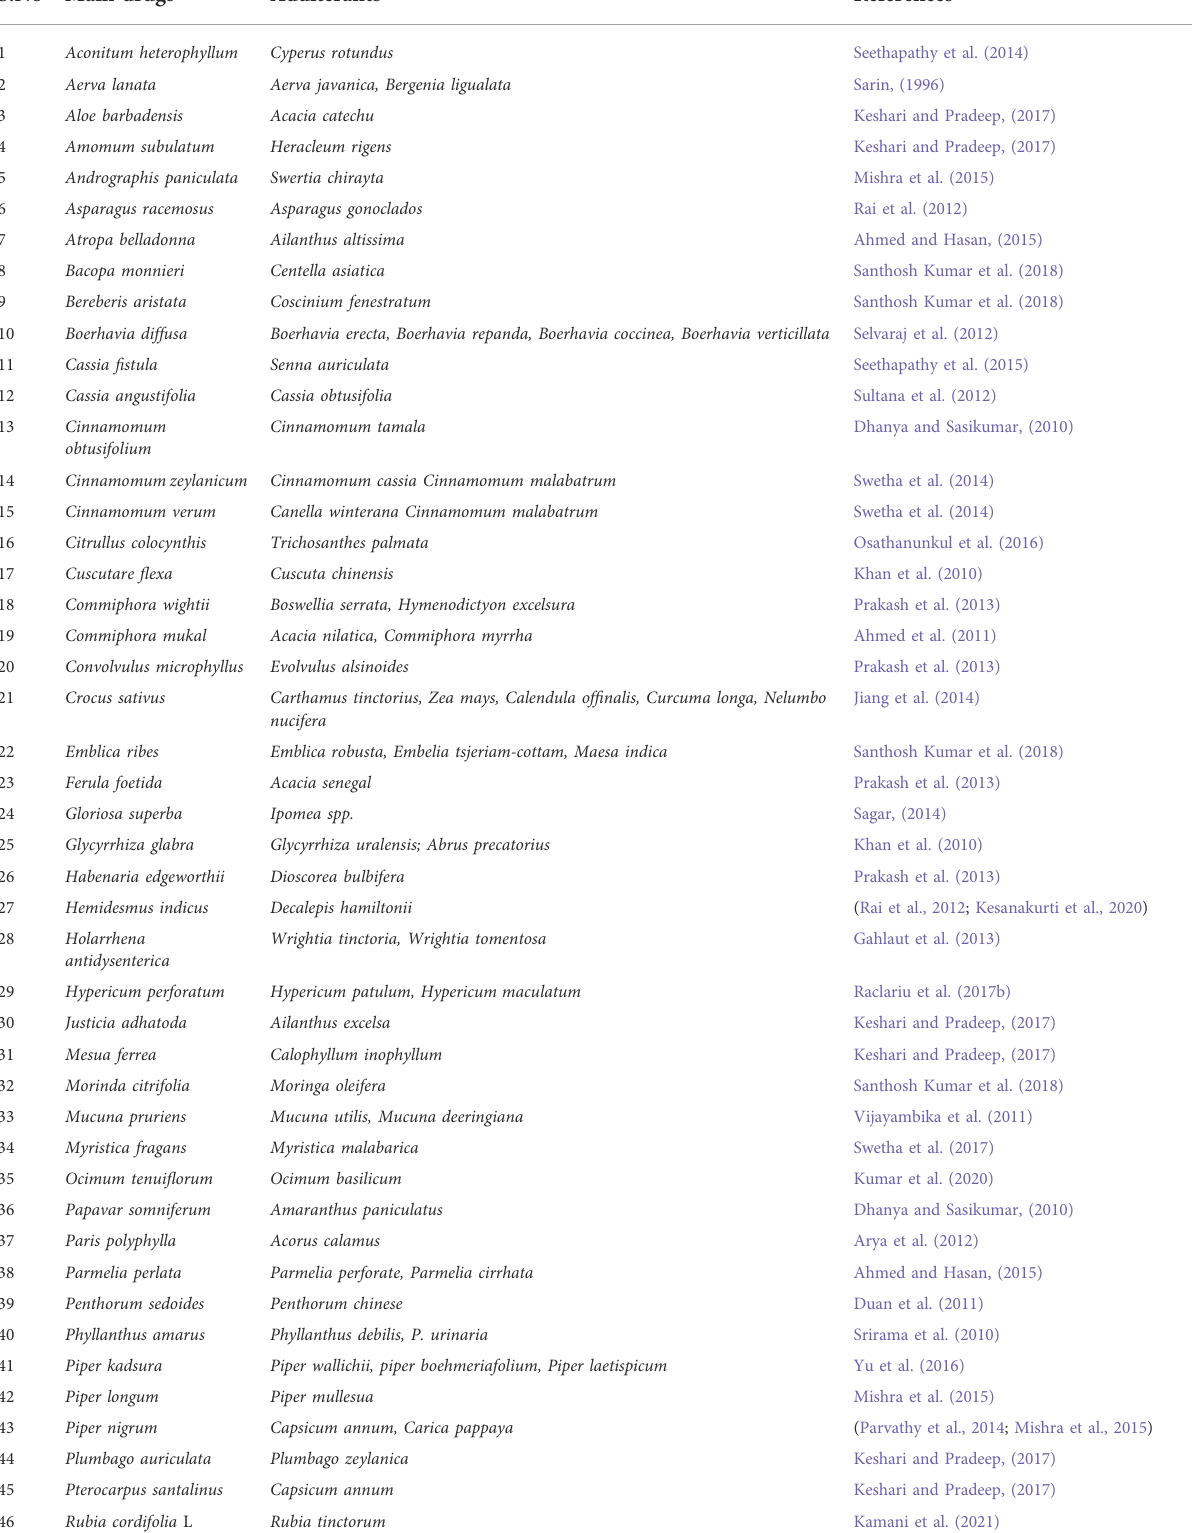
TABLE 1 List of known adulterants/substitutes in the herbal drug